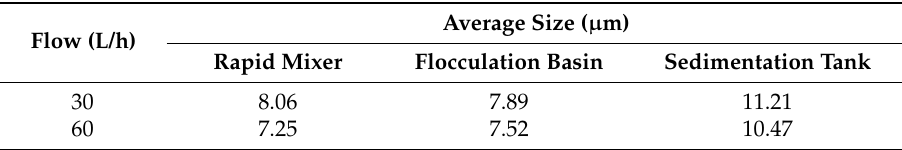
Table 4. Average size in different process units.